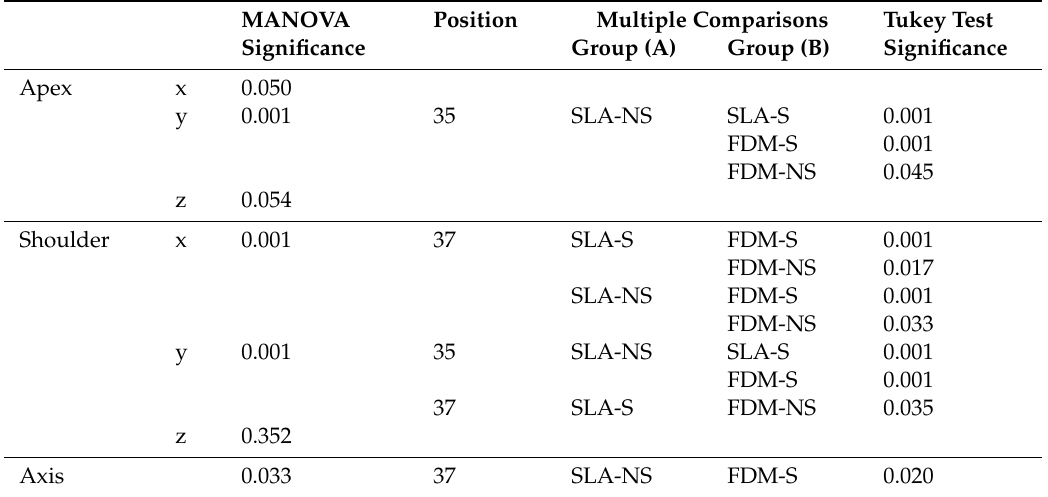
Table 2. Results of MANOVA with post hoc pairwise comparisons in case of p <